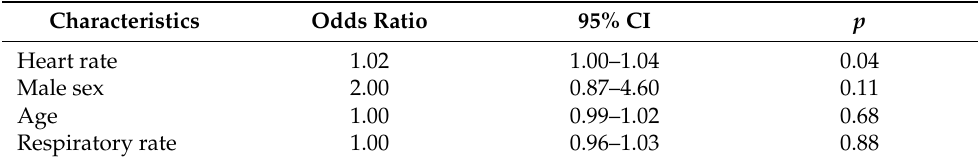
Table 3. Predictors of 1 h bundle